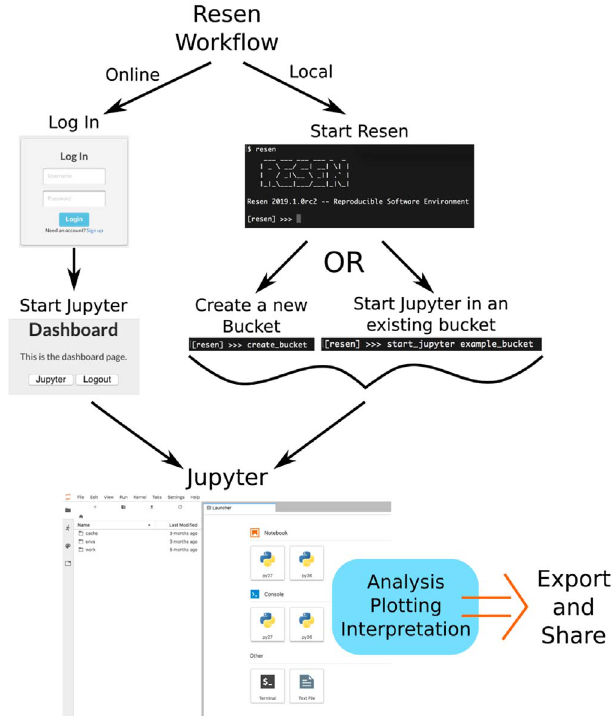
Fig. 2. Resen can be used both online through the InGeO website or locally to take advantage of local computing